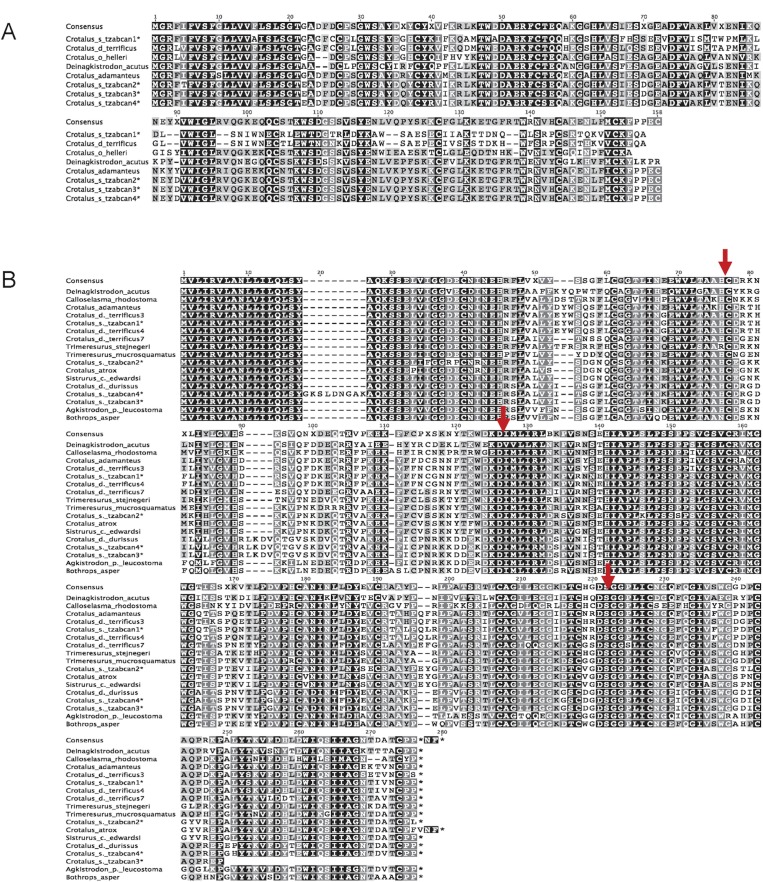
Aligned Middle American Rattlesnake (Crotalus simus tzabcan) C-type lectins (A) and serine proteases (B). A) Four unique venom-based C-type lectin transcripts (asterisks) were identified for C. s. tzabcan and aligned to other crotaline species. Identical nucleotide sequences are shaded and corresponding GenBank accession numbers are as follows: Crotalus_adamanteus (AEJ31974.1), Deinagkistrodon_acutus (AAM22790.1), Crotalus_d_terrificus (Q719L8.1), and Crotalus_o_helleri (AEU60004.1). B) Venom-based serine proteases cDNA sequences (asterisks) were also obtained from C. s. tzabcan and were aligned with toxins from several other species; identical nucleotide sequences are shaded, and the catalytic triad composed of Ser195, Asp102, and His57 associated with thrombin-like activity in snake venom serine proteases are identified (arrowheads). Isoform 3 from C. s. tzabcan is a partial sequence. GenBank accession numbers are as follows: Agkistrodon_p_leucostoma (HQ270466.1), Bothrops_asper (DQ247724.1), Crotalus_d_terrificus7 (EU360954.1), Crotalus_d_terrificus4 (EU360952.1), Crotalus_d_terrificus3 (EU360951.1), Crotalus_d_durissus (DQ164401.1), Sistrurus_c_edwardsi (DQ464239.1), Trimeresurus_mucrosquamatus (X83225.1), Crotalus_adamanteus (HQ414118.1), Calloselasma_rhodostoma (L07308.1), Deinagkistrodon_acutus (AY861382.1), Trimeresurus_stejnegeri (AF545575.1), and Crotalus_atrox (AF227153.1).